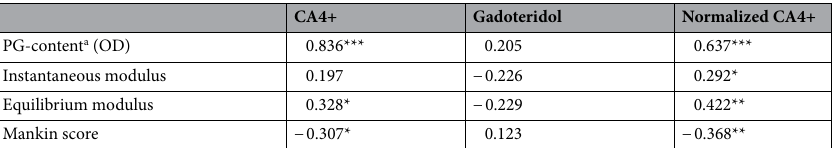
Table 1. Spearman’s correlation coefficients ( ρ ) between the contrast agent partitions and reference data in bulk cartilage. a Optical density (OD) represents proteoglycan (PG) content of the cartilage.